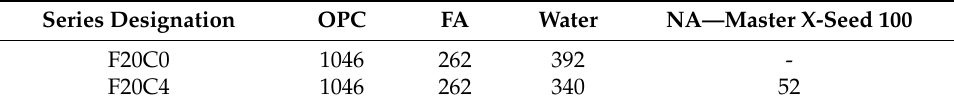
Table 1. Components of the F20C0 and F20C4 mixtures (kg / m 3